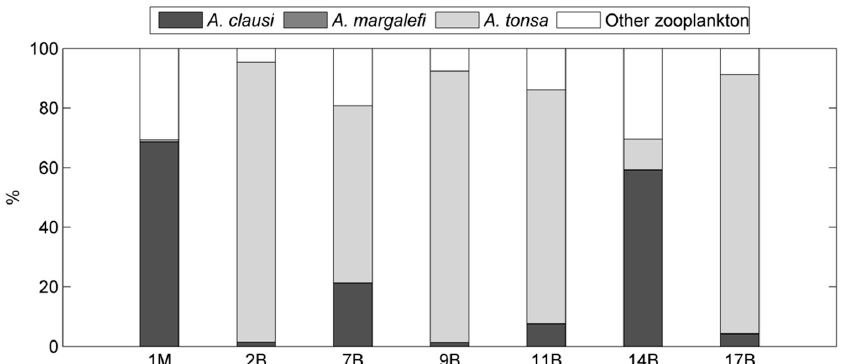
Figure 7. Relative abundance, station by station, of A. tonsa with respect to the other Acartia species and the remaining zooplankton during 2003–2004 period.